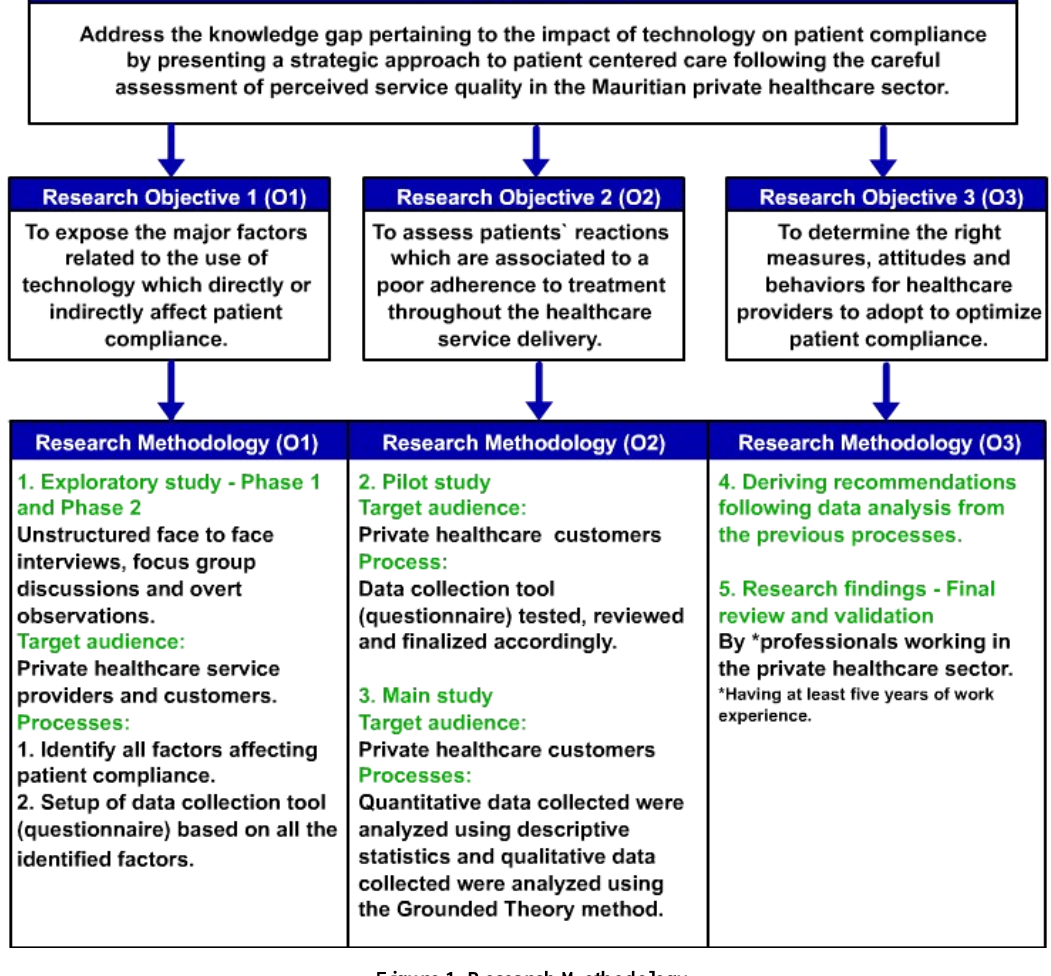
Figure 1. Research